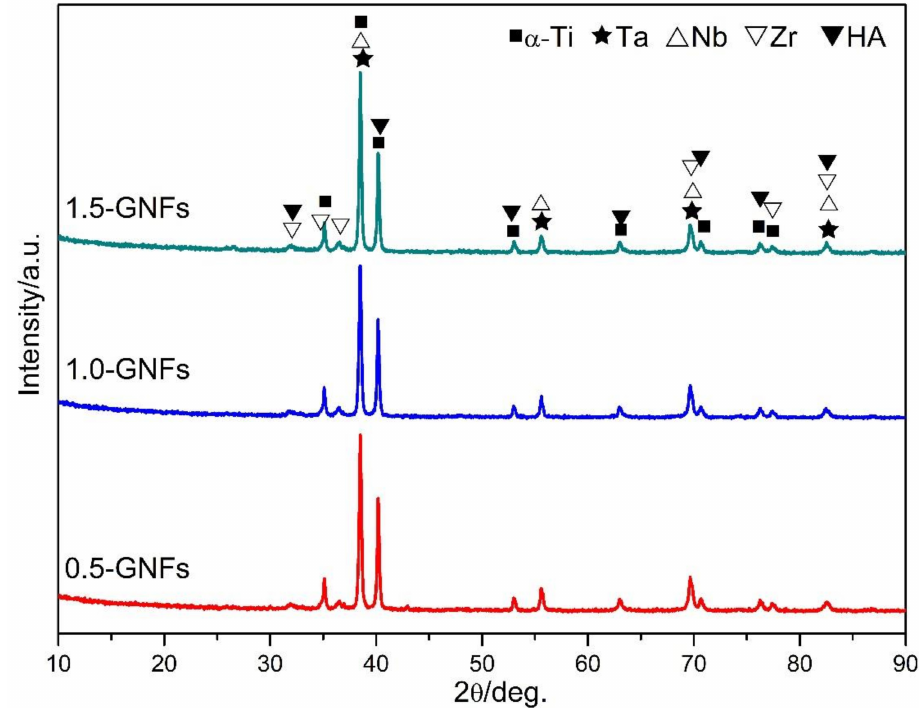
Figure 2. X-ray diffractograms of the milled powders with different contents of graphene nano-flakes (GNFs) (0.5, 1.0, and 1.5 wt